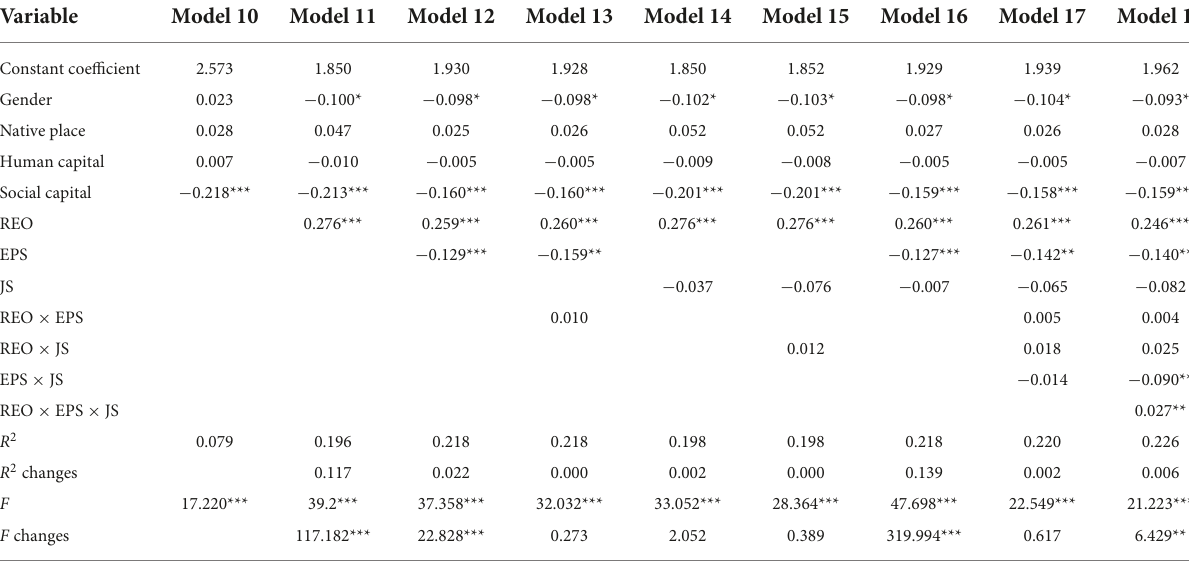
Dependent variable: School pressure